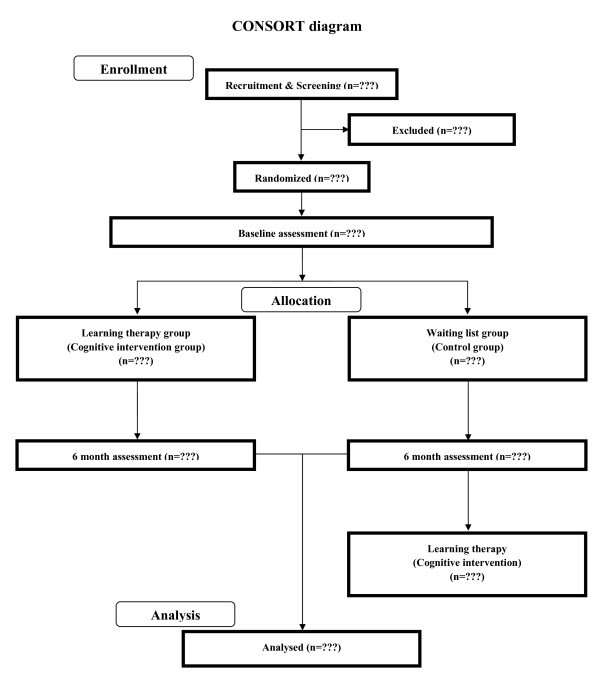
CONSORT flowchart.